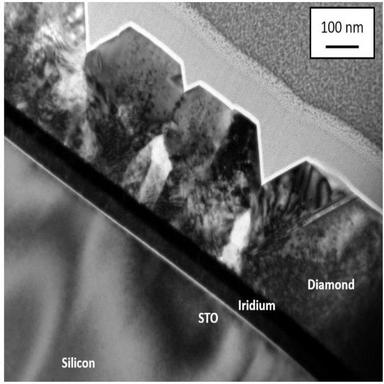
TEM bright field image of the full stacking of the diamond/Ir/STO/Si (001) sample.